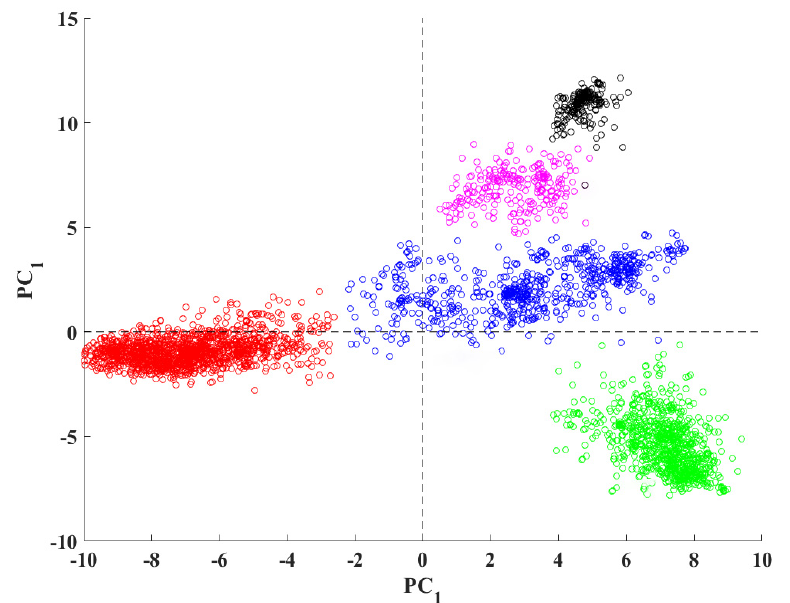
Figure 4. PCA analysis of the D-ratio of the 96 3-mer motifs of 3000 hepatitis B virus (HBV) sequences, calculated by VIRMOTIF.